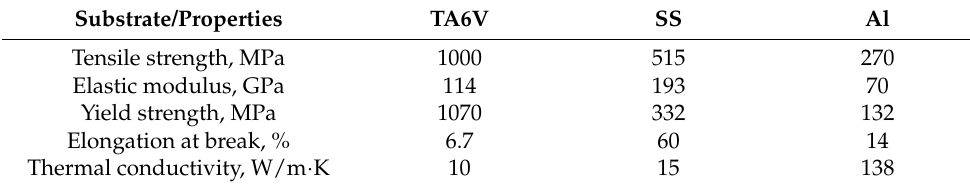
Table 1. The properties of the metallic substrates used in the cold spray deposition and wipe tests.